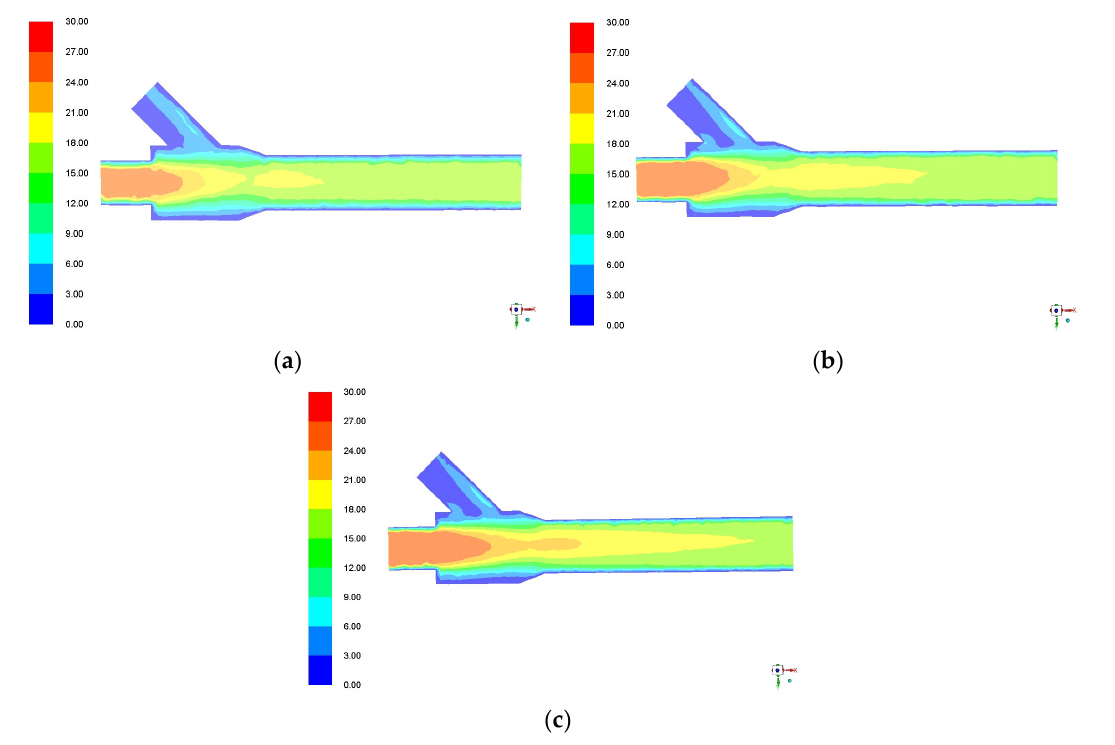
Figure 4. Velocity nephogram with different grid numbers. ( a ) Velocity nephogram with 8285 grids; ( b ) Velocity nephogram with 16,476 grids; ( c ) Velocity nephogram with 28,886 grids.